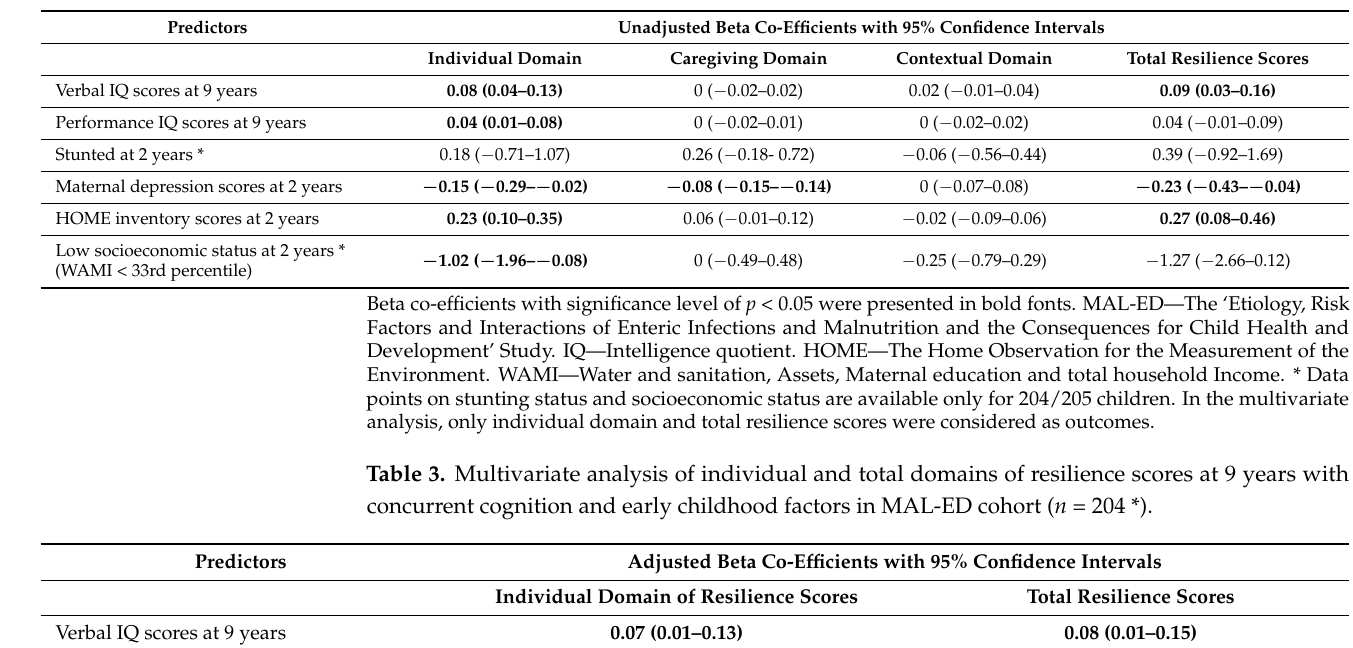
Table 2. Bivariate analysis of various domains of resilience scores at 9 years with concurrent cognition and early childhood factors in the MAL-ED cohort ( n = 205).